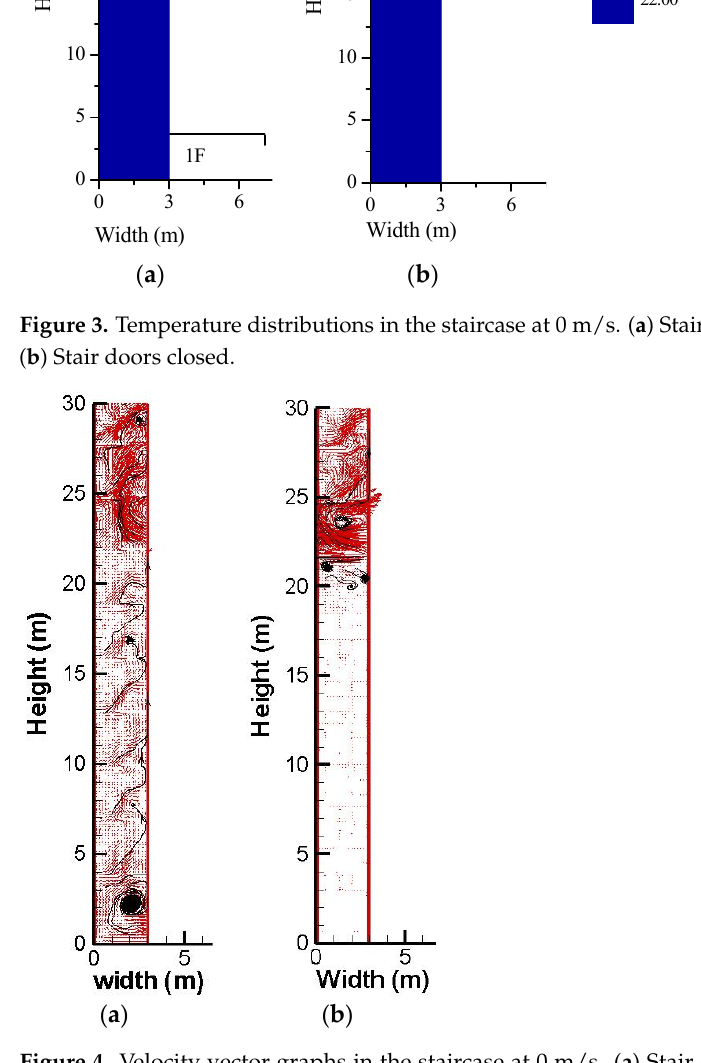
Figure 4. Velocity vector graphs in the staircase at 0 m/s. ( a ) Stair door opened on the first floor. ( b ) Stair doors